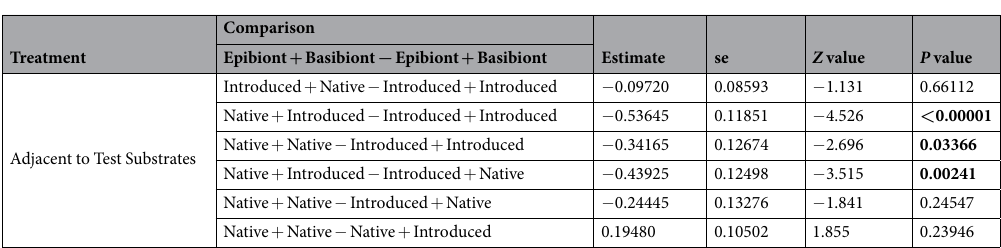
Table 2. Results of Tukey contrasts following a generalised mixed effects model comparing bryozoan larval settlement on space adjacent to test encrusting basibiont